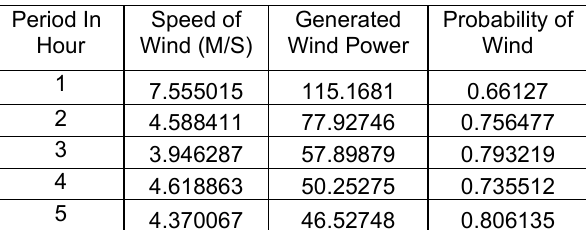
Table 1. Probability of Wind power